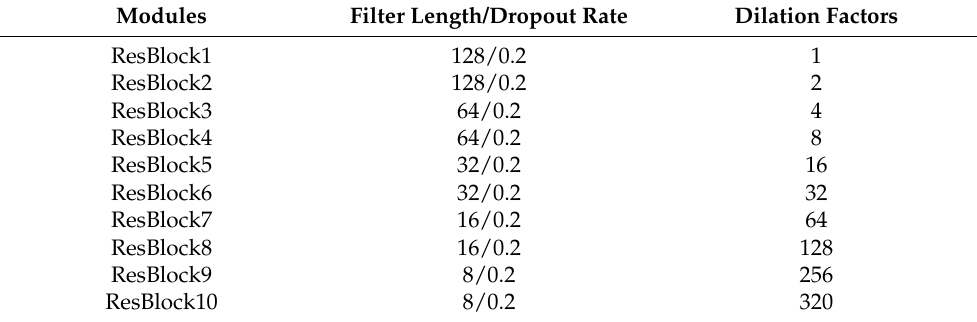
Table 3. Some key parameters of CNN models with the proportion of the input sequence α = 0.5. Modules Filter Length/Dropout Rate Dilation Factors ResBlock1 128/0.2